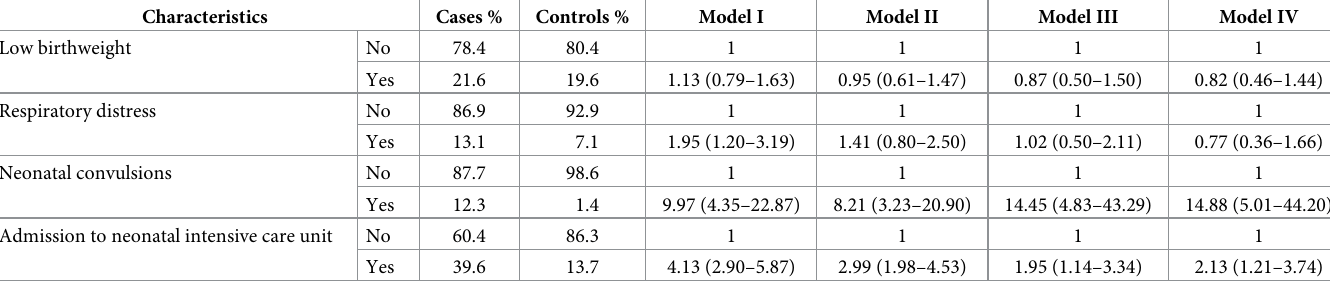
Table 4. Postconception neonatal predictors of autism spectrum